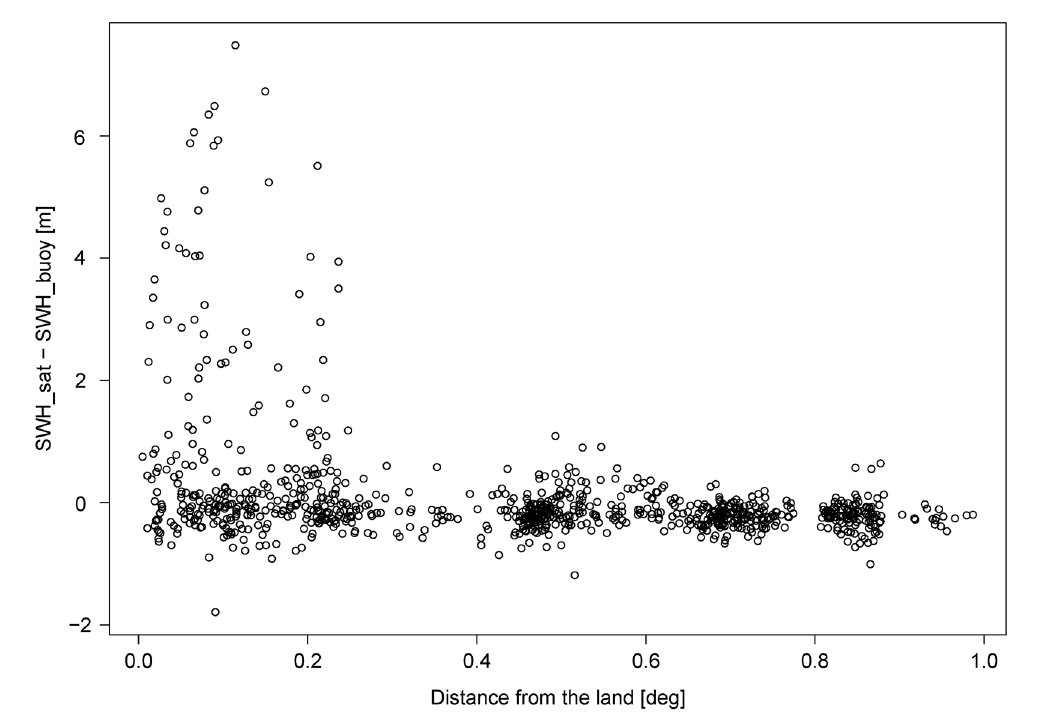
Fig. 6. Difference between the GEOSAT significant wave height and in situ data versus ice distance from the